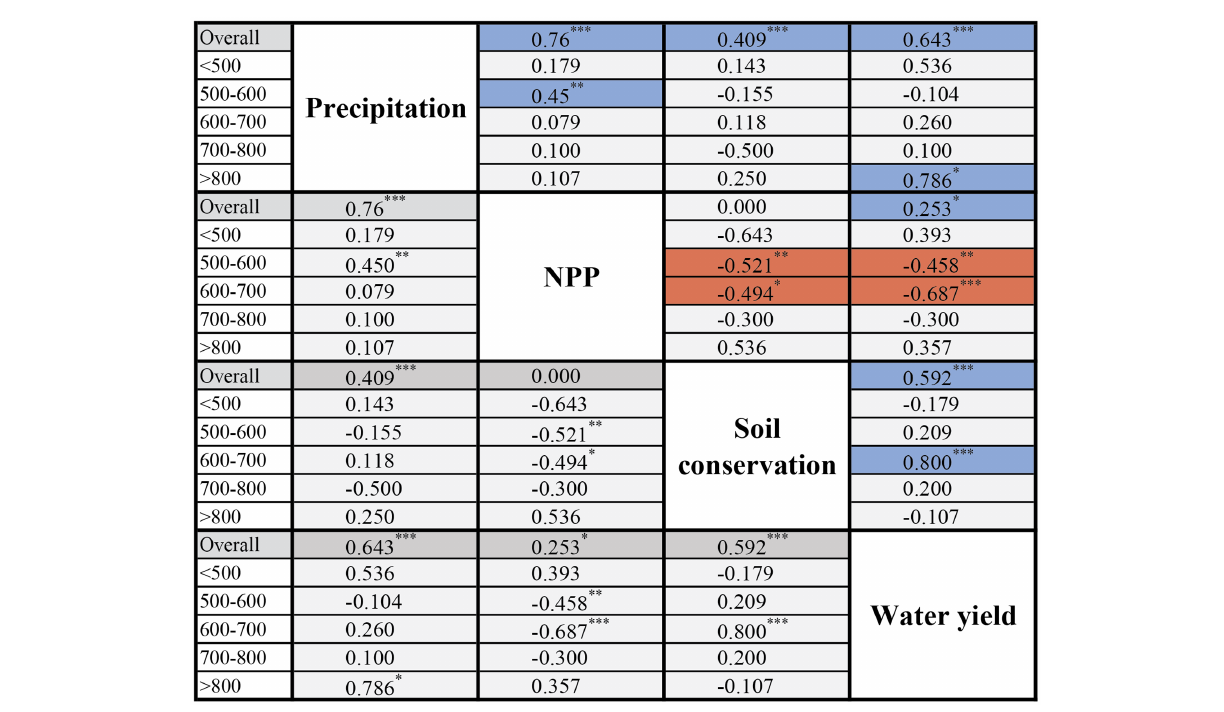
FIGURE 2 Relationship between ESs and precipitation. *** p < 0.001; ** p < 0.01; * p < 0.05. Blue and red represent significant positive and negative, respectively. Gray represents all the study areas, and successive ones represent different precipitation